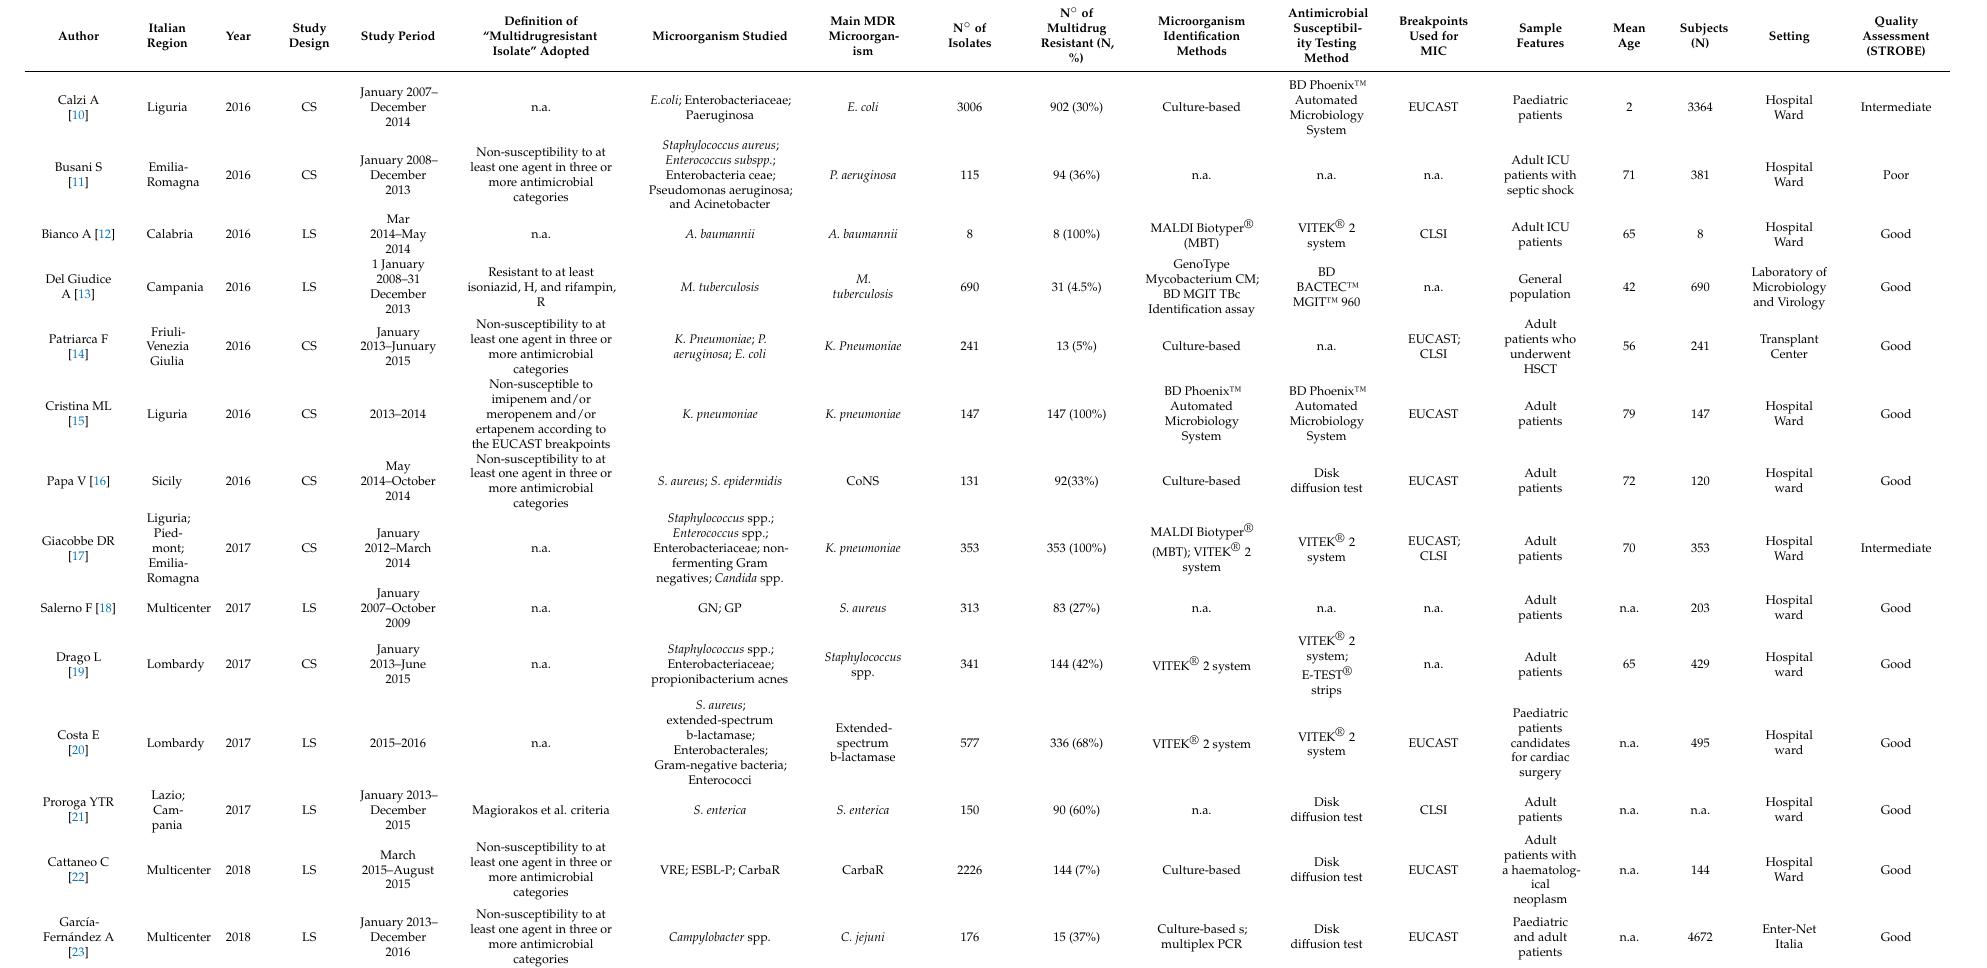
Table 1. Included studies conducted in Italy focusing on AMR and presenting original data sorted by year of